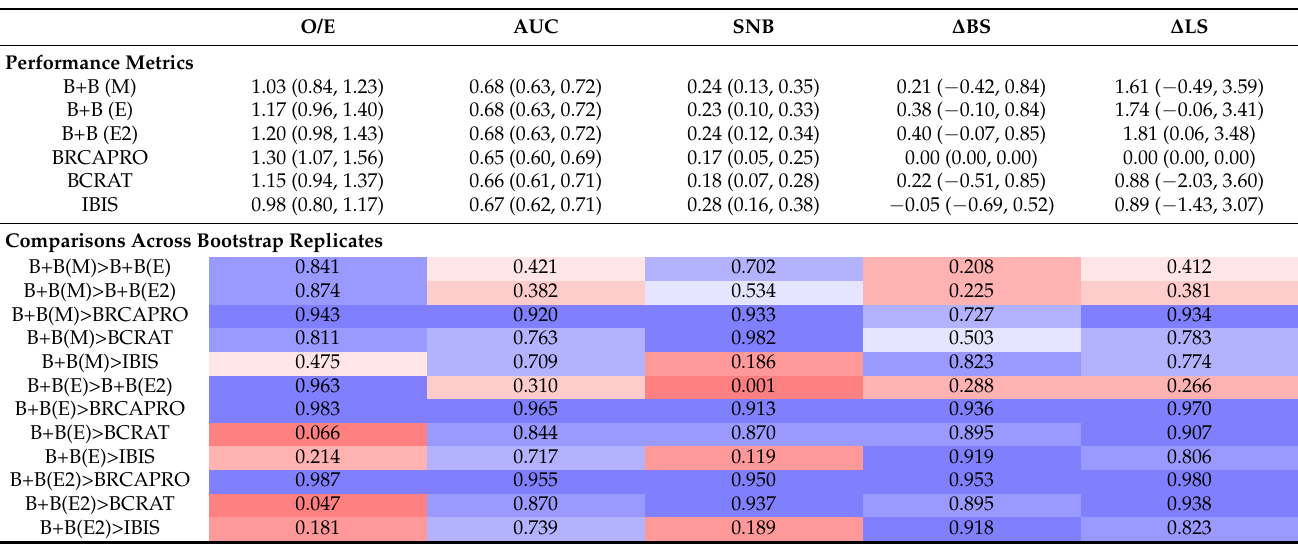
Table 3. Five-year performance in the entire CGN cohort. B+B: BRCAPRO + BCRAT. ∆ BS: % relative improvement in Brier Score compared to BRCAPRO. ∆ LS: % relative improvement in logarithmic score compared to BRCAPRO. The “Comparisons Across Bootstrap Replicates” section shows pair- wise comparisons involving the combination models across 1000 bootstrap replicates of the validation dataset; the row for A > B shows the proportion of bootstrap replicates where model A outperformed model B with respect to each metric. Proportions > 0.5 are highlighted in blue (with darker shades of blue for higher proportions) and proportions ≤ 0.5 are highlighted in red (with darker shades of red for lower